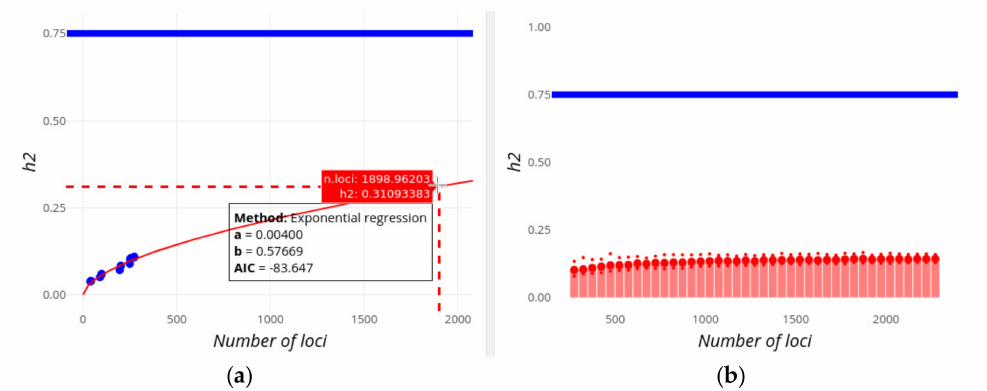
Figure 5. Screenshot of GWEHS (Genome-Wide E ff ect size and Heritability Screener) showing the inferences on the increase of heritability ( h 2 ) as new loci are found for Digestive disease (i.e., Crohn’s disease and Inflammatory bowel disease), using the default parameters. ( a ) Inferences using a regression method of the change in heritability with the number of loci. Blue points indicate observed values from di ff erent sets of PMIDs. The red line corresponds to the regression fit. Note that in this image we use the utility to toggle spike lines in order to read the expected value of h 2 at a given number of loci (shown in a red box). A text box includes the distribution parameters and the Akaike information criterion (AIC) value. ( b ) Inferences using a regression method on the parameters of the distribution of e ff ect sizes and MAF, and sampling heritability values. The blue line indicates the assumed familial heritability. The red bars correspond to the heritability sampled. The red points show the median (large point), and 0.975 and 0.025 quantiles of that heritability (upper and lower small points,